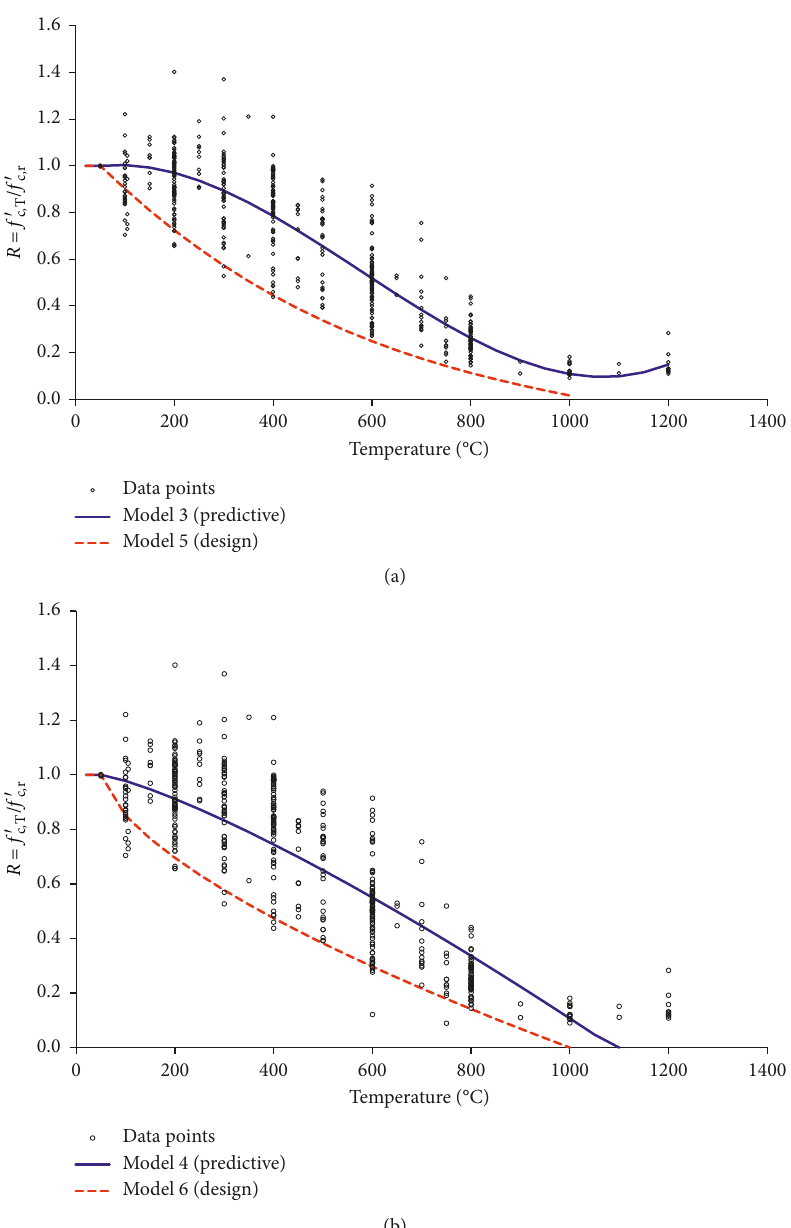
Figure 6: Performance of the proposed models in comparison with experiments: (a) Model 3 and Model 5 and (b) Model 4 and Model